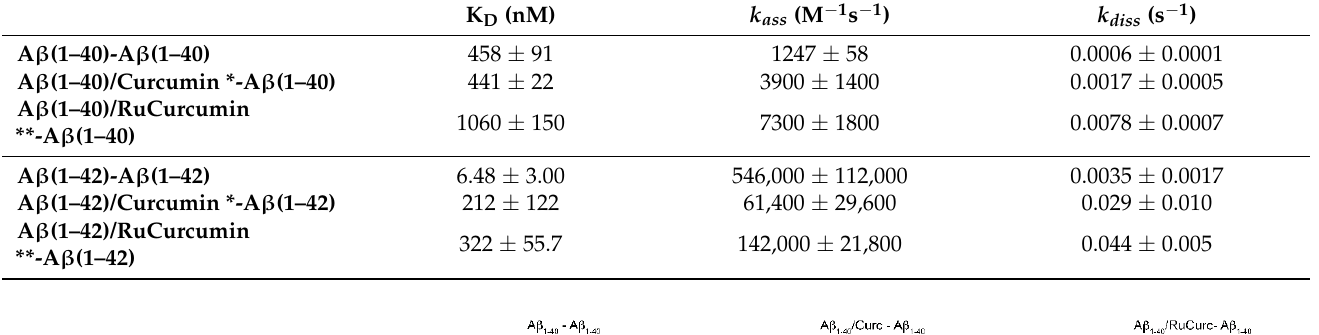
Table 3. Competitive effect on amyloid-amyloid binding. Comparison of kinetic and equilibrium parameters for the amyloid-amyloid binding in the absence and in the presence of saturating curcumin (*) and RuCurcumin (**).